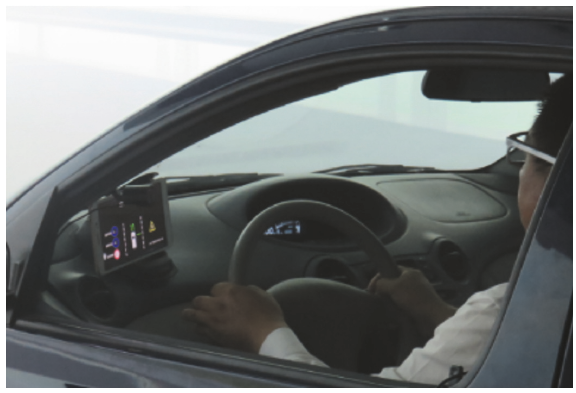
Figure 3: Driving experiment of vehicle connected environment.